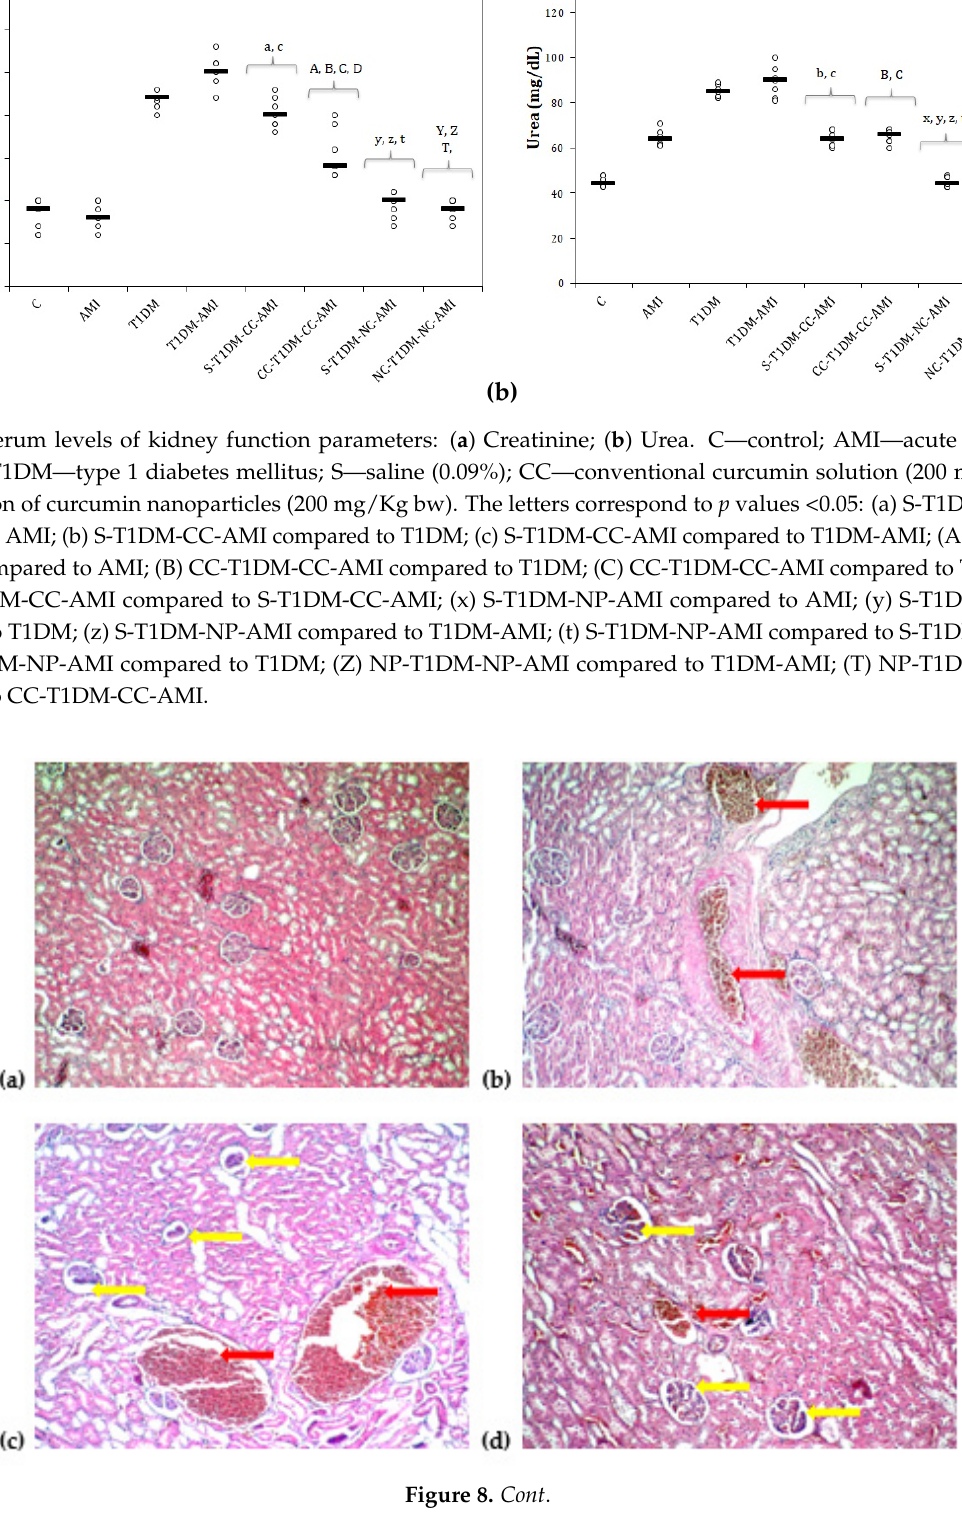
Figure 8. Histopathological examinations of the kidney tissue. ( a ) C (normal architecture of the kidneys), ( b ) AMI (blood stasis with well recognizable integral erythrocytes in a congested blood vessel (red arrow)), ( c ) T1DM (glomerular col- lapse (yellow arrow) and blood stasis with well recognizable integral erythrocytes in a congested blood vessel (red arrow)), ( d ) T1DM-AMI (glomerular collapse (yellow arrow) and blood stasis with well recognizable integral erythrocytes in a congested blood vessel (red arrow)), ( e ) S-T1DM-CC-AMI (blood stasis (red arrow)), (f) CC-T1DM-CC-AMI (blood stasis (red arrow)), ( g ) S-T1DM-NC-AMI (blood stasis (red arrow)), ( h ) NC-T1DM-NC-AMI (normal architecture of the kidneys).